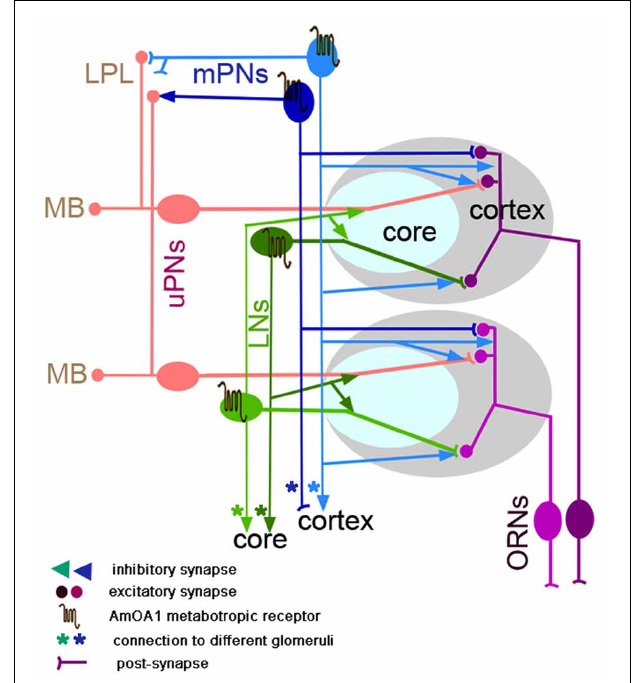
FIGURE 7 | Schematic representation of the neural network proposed for a glomerulus in the honey bee (model architecture based on Fonta et al., 1993; Abel et al., 2001; Nishino et al., 2009; Meyer and Galizia, 2012; Girardin et al., 2013). Octopamine is released into the whole glomerulus in both core and cortex and acts on the GABArgic local interneurons (LNs) and on GABAergic multiglomerular projection neurons (mPNs). Each glomerulus has a uniglomerular PN (uPNs) that branches into both core and cortex areas of the glomerulus. uPNs receive excitatory synapses from ORNs in the cortex area and inhibitory synapses from hetero-multiglomerular local neurons from neighboring glomeruli in the core area. The uPNs also receive inhibitory synapses in the cortex that come from the mPNs. In the glomerulus there are GABAergic and non-GABAergic multiglomerular LNs. For simplicity, only one type of the GABAergic LNs is shown in the glomeruli; LNg (LN1 or heteroLN in Figure 1 ) that branches in all areas of the glomerulus (cortex and core) where it receives excitatory synapses from ORN in the cortex and inhibitory synapses in the core and sends the inhibitory output into the neighboring glomeruli. Both types of GABAergic neurons (LNs and mPNs) express AmOA1 receptors in the glomerulus. Based on our indirect evidence of AmOA1 and GABA stainings in glomeruli, we hypothesize two possible mPNs connections, one that receives excitatory synapses from ORNs in the glomerulus cortex and makes synapses in the LH as well as another that receives synaptic input from LPL and LH and makes synapses onto the processes in the cortex. Future physiological and anatomical studies will clarify the branching patterns that we proposed for